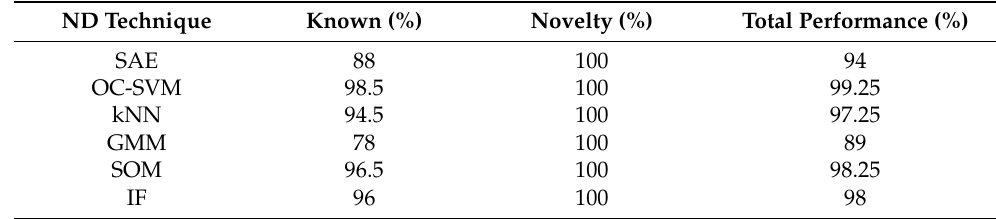
Table 5. Numerical results of the novelty detection obtained for the first case study of the